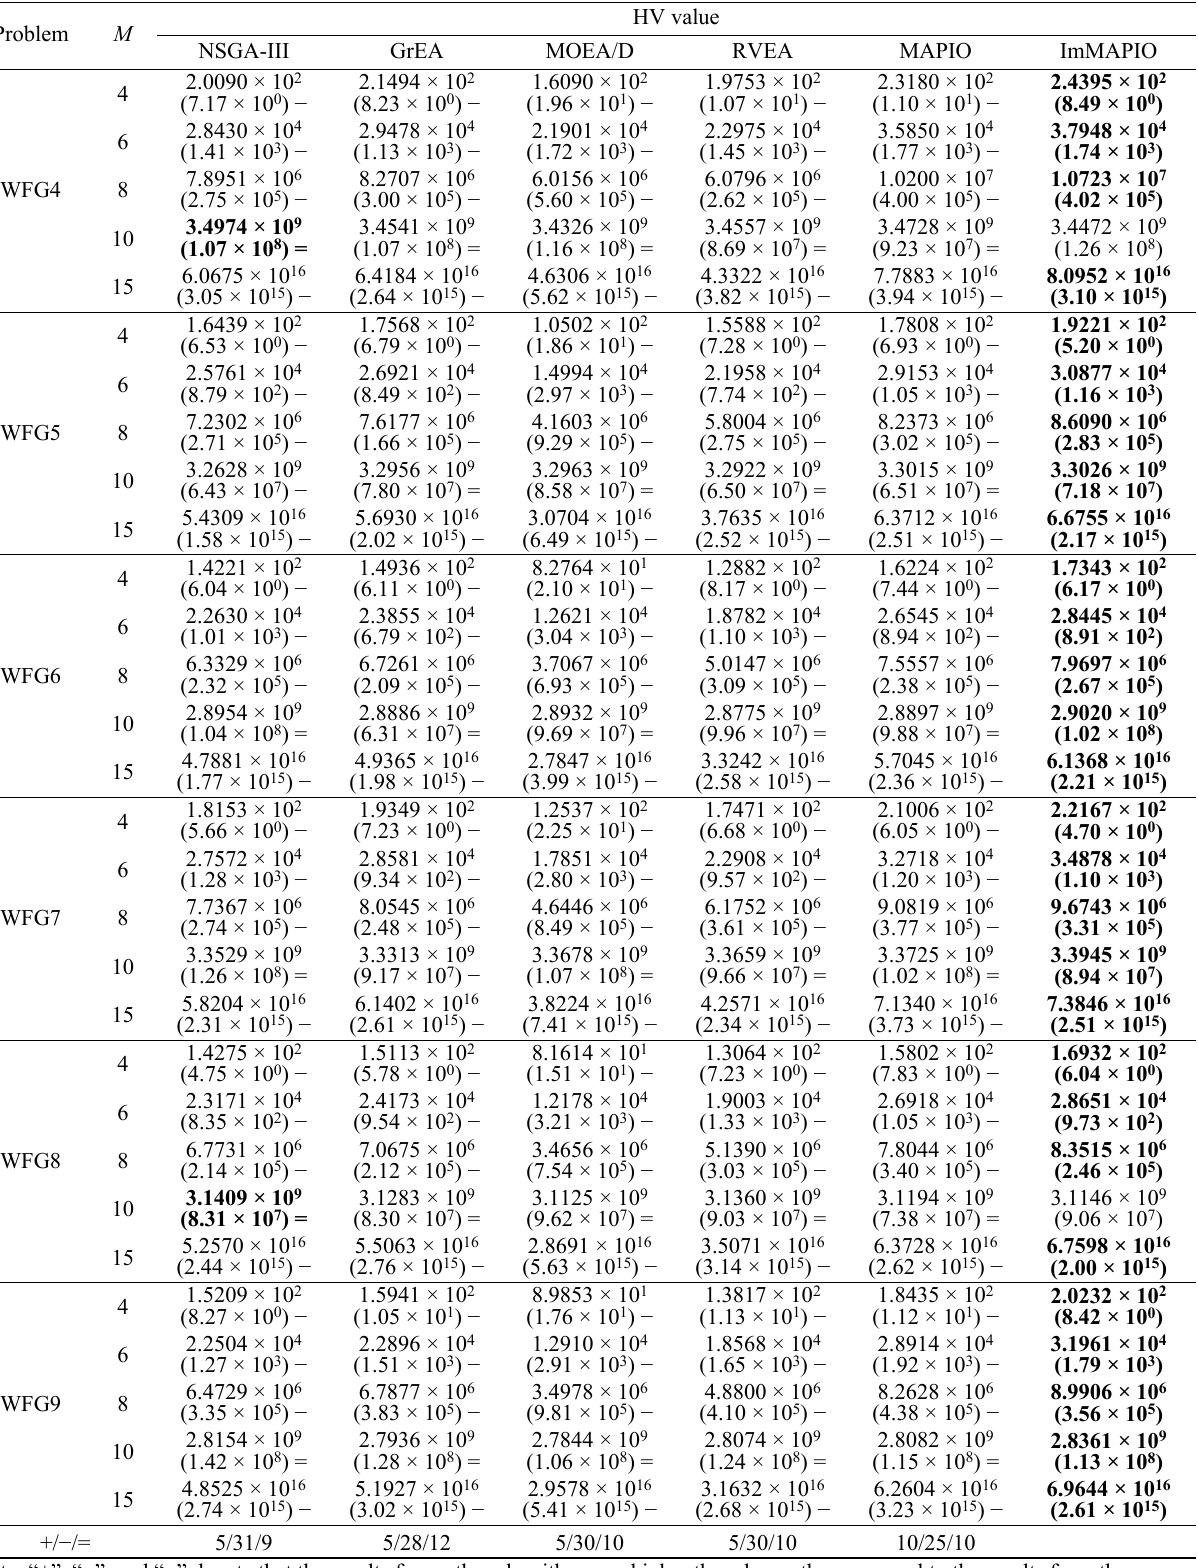
Table 5 HV values of these algorithms for different objectives in the WFG test